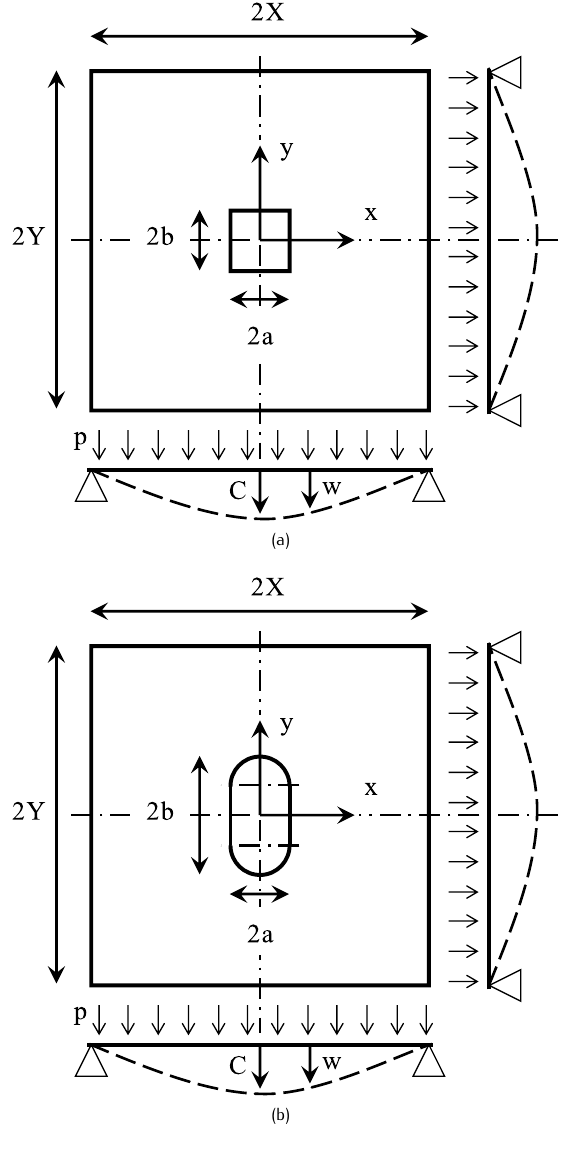
Figure 1. Plate-with-hole geometry and large-deformation mode shape for (a) rectangular hole and (b) rectangular hole with circular